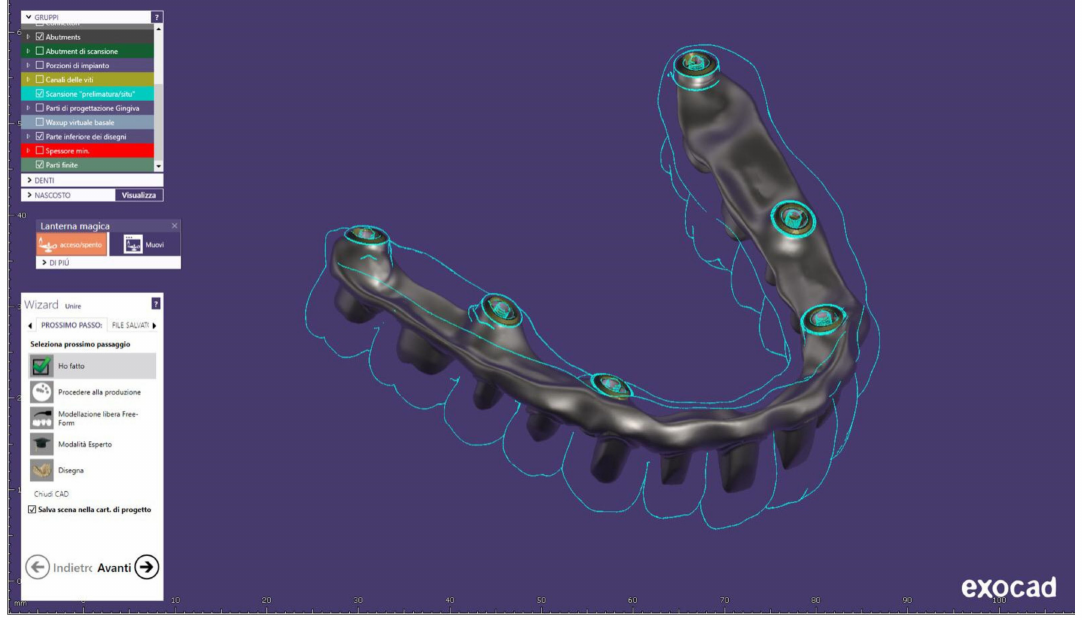
Figure 4. Sample of computers planning and realization of prosthodontics structure before starting the treatment over